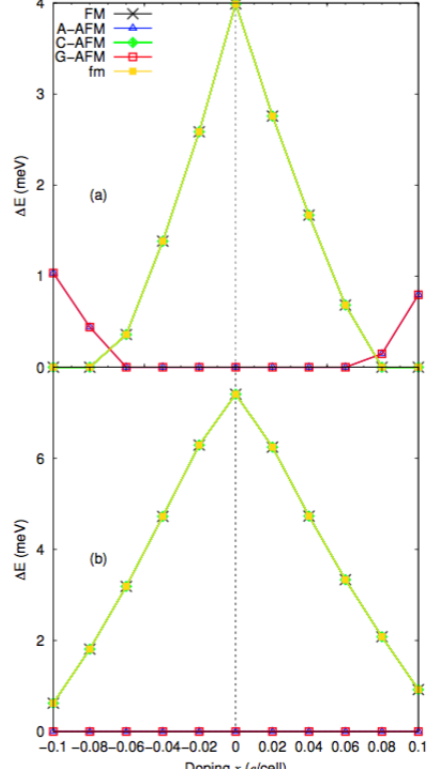
Fig. 6. Total energy difference ∆E with respect to the ground state of bilayer 6-ZGNR (a) and 14-ZGNR (b) at thickness d = 3.35 A˚ as a function of doping x